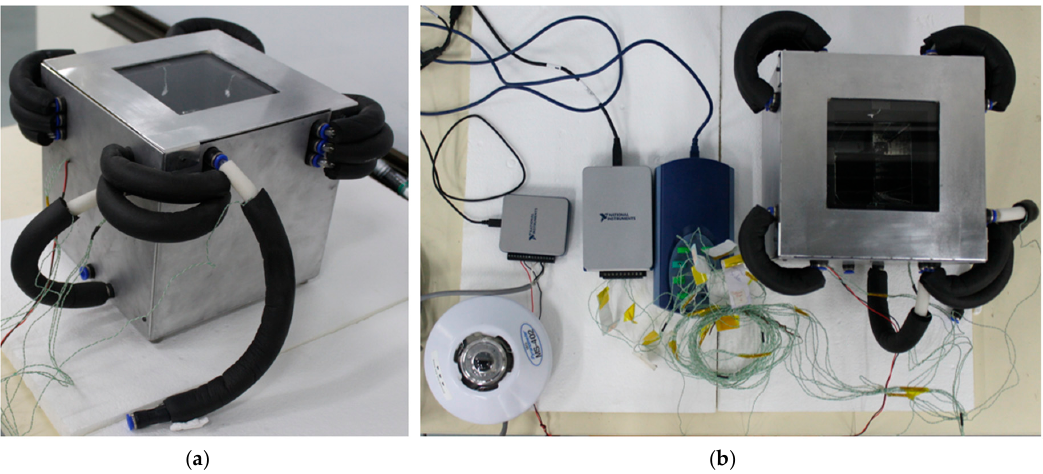
Figure 10. ( a ) Completed A/R CCPC module. ( b ) Whole setup with measuring instruments and sensors attached.